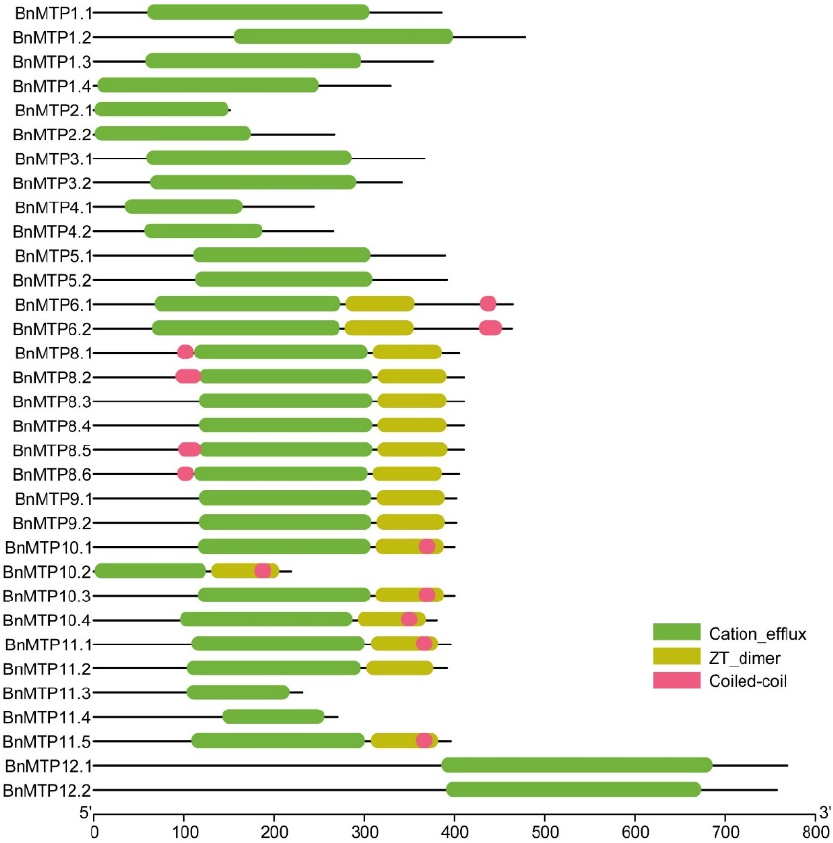
Figure 4. Distribution of the conserved domain in BnMTP proteins. Green boxes indicated the cation_efflux domain; yellow boxes indicated ZT_dimers, and pink boxes indicated a coiled-coil structure.